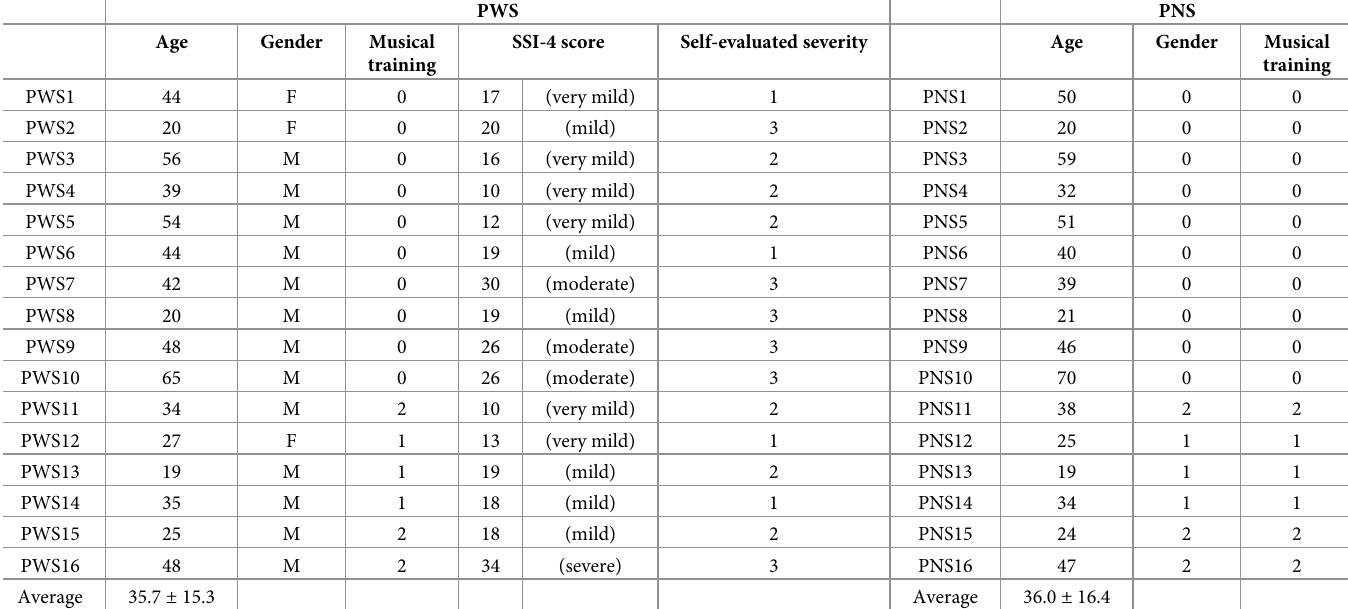
Table 1. Female and male (F, M) people who stutter (PWS) and not stutter (PNS), with “age” and “musical training” (1: “none”, 2: “moderate”, 3: “high”). For the PWS, the stuttering severity was both self-evaluated (1: “mild”, 2: “moderate”, 3: “severe”) and evaluated with the SSI-4